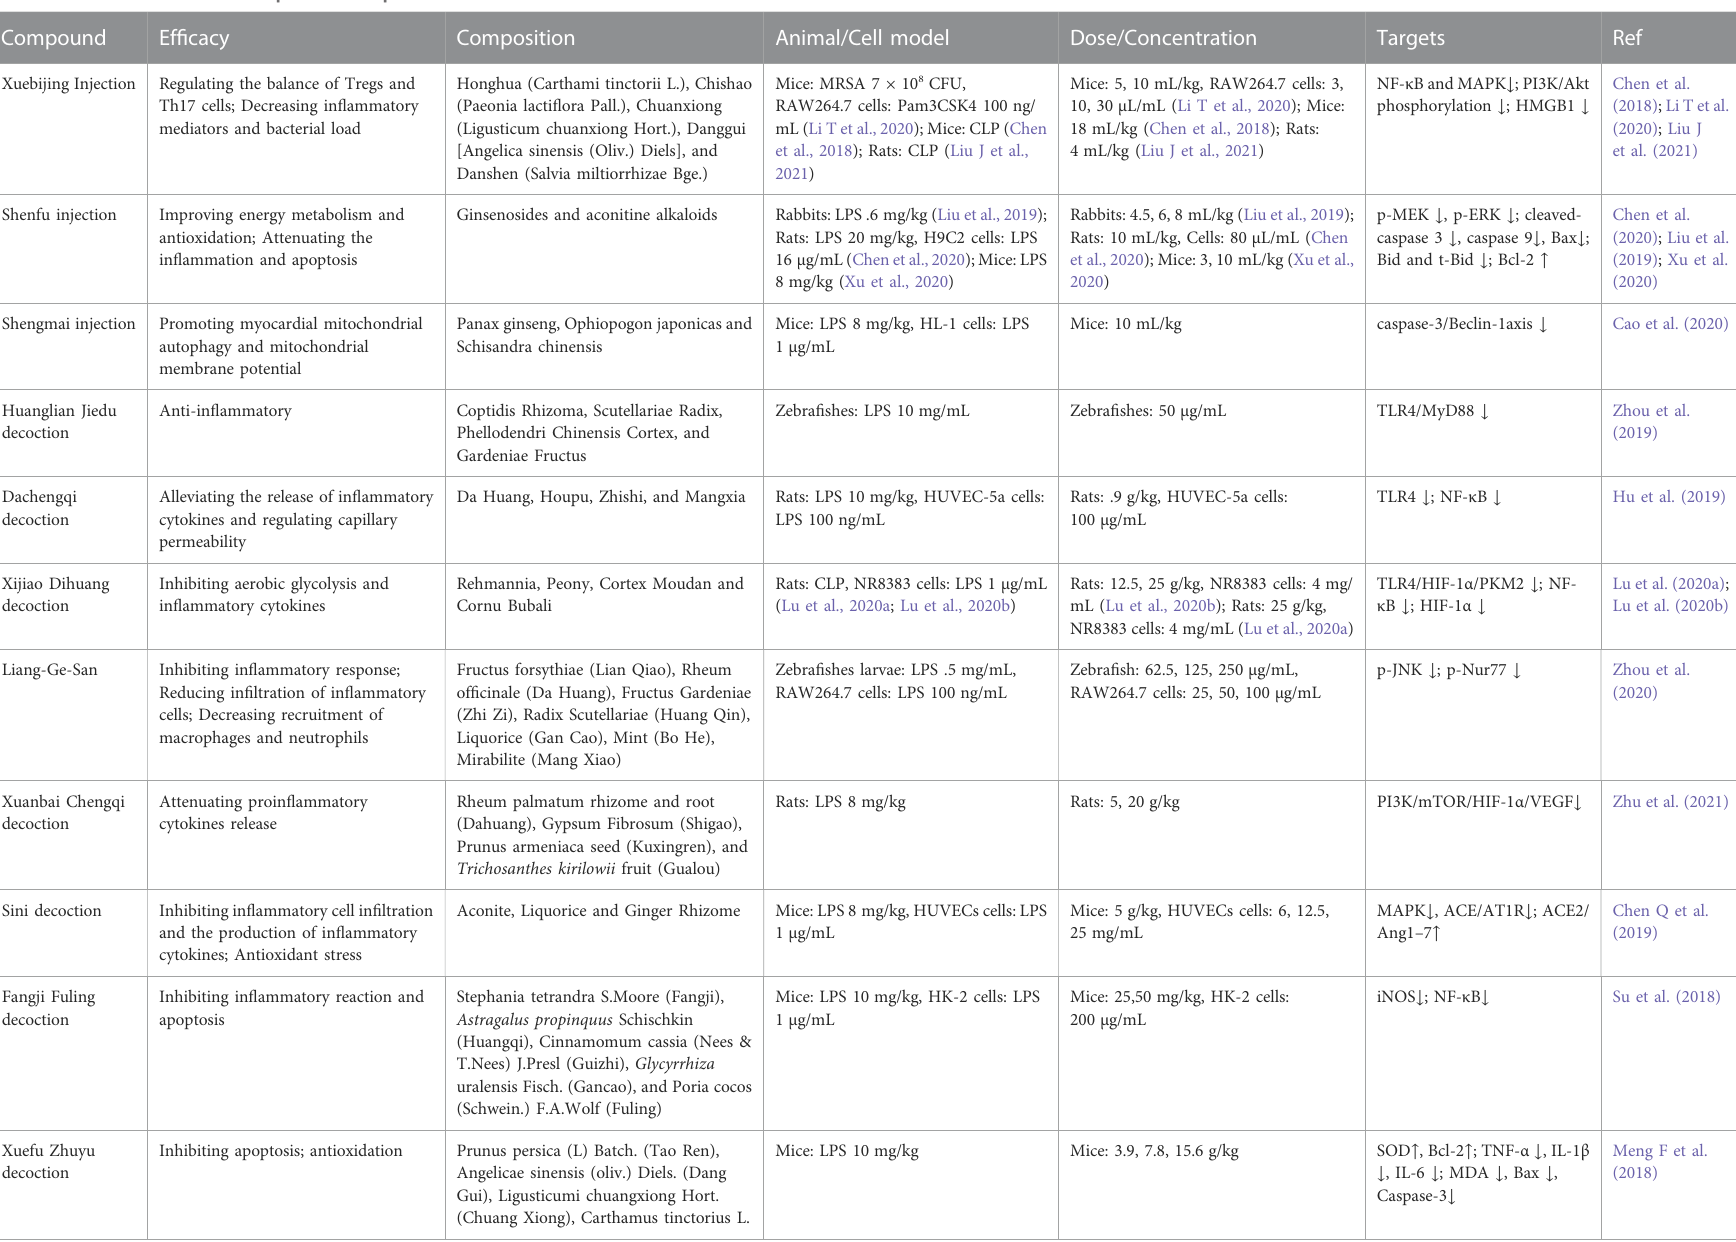
TABLE 1 Characteristics of TCM compounds on